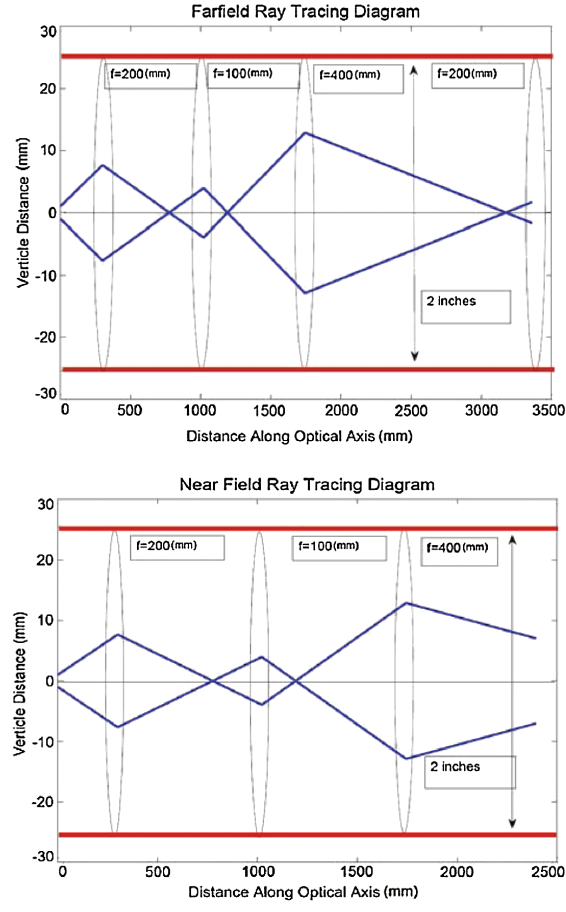
FIG. 4. (Color) Ray tracing plots for the near field and far field optical